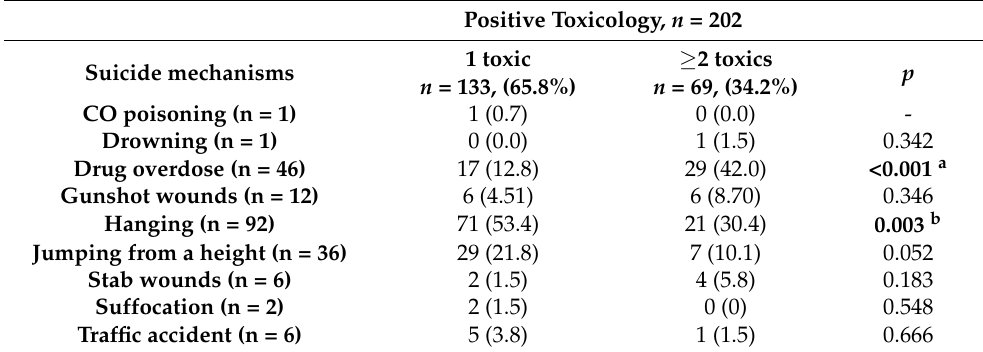
Table 2. The number of toxics found in the corpse with different suicide